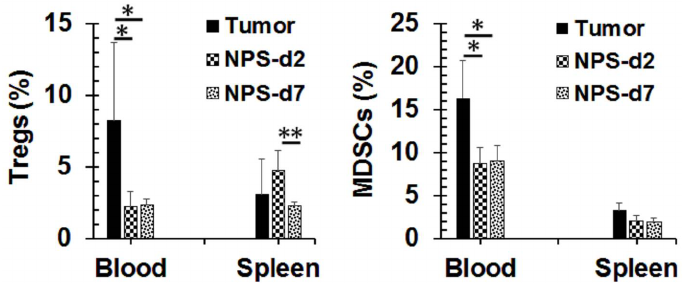
Figure 6. Changes of the frequencies of immune suppressor cells in the blood and spleen after NPS treatment. Blood and spleens were collected from tumor-bearing animals (tumor, n = 4), or animals treated with NPS on day 2 (NPS-2, n = 5) or day 7 (NPS-7, n = 5) post-treatment. Regulatory T cells (Tregs) or myeloid-derived suppressor cells (MDSCs) were analyzed with flow cytometry. * p < 0.05. ** p < 0.01 for NPS-2 or NPS-7 vs. tumor by One Way ANOVA.